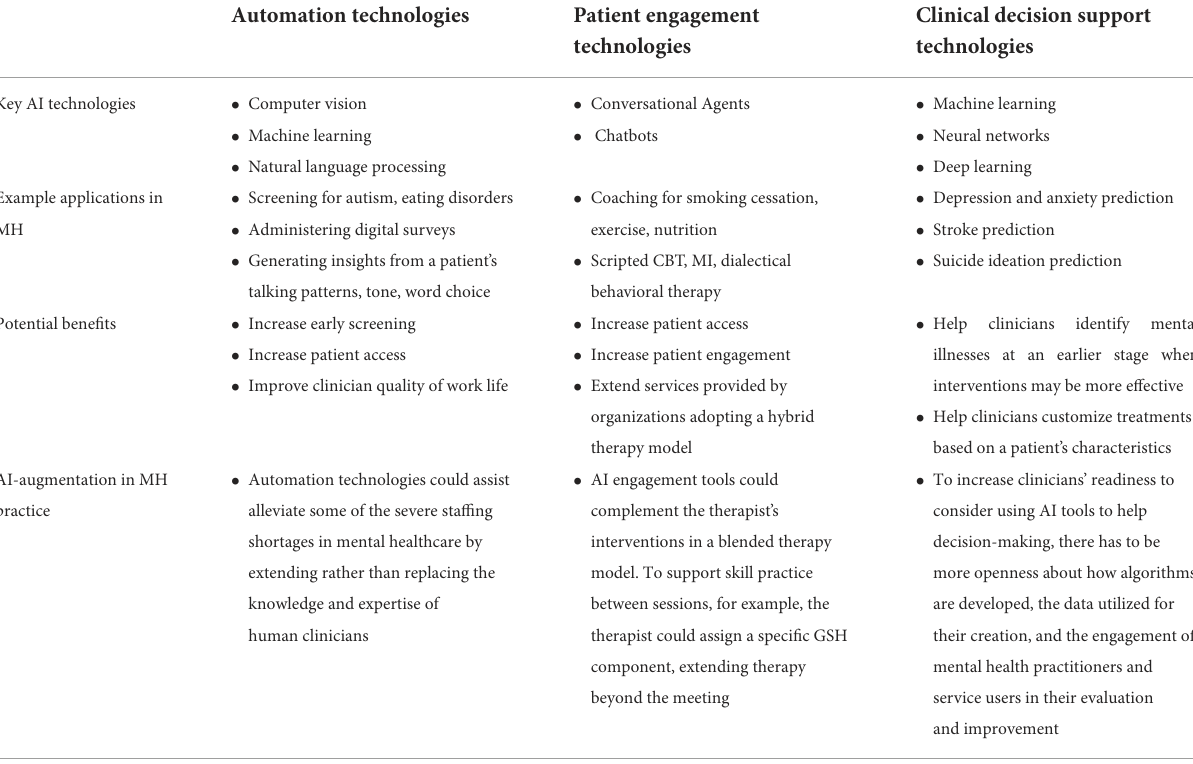
TABLE 1 Key AI technologies, example applications in mental healthcare, and potential benefits.